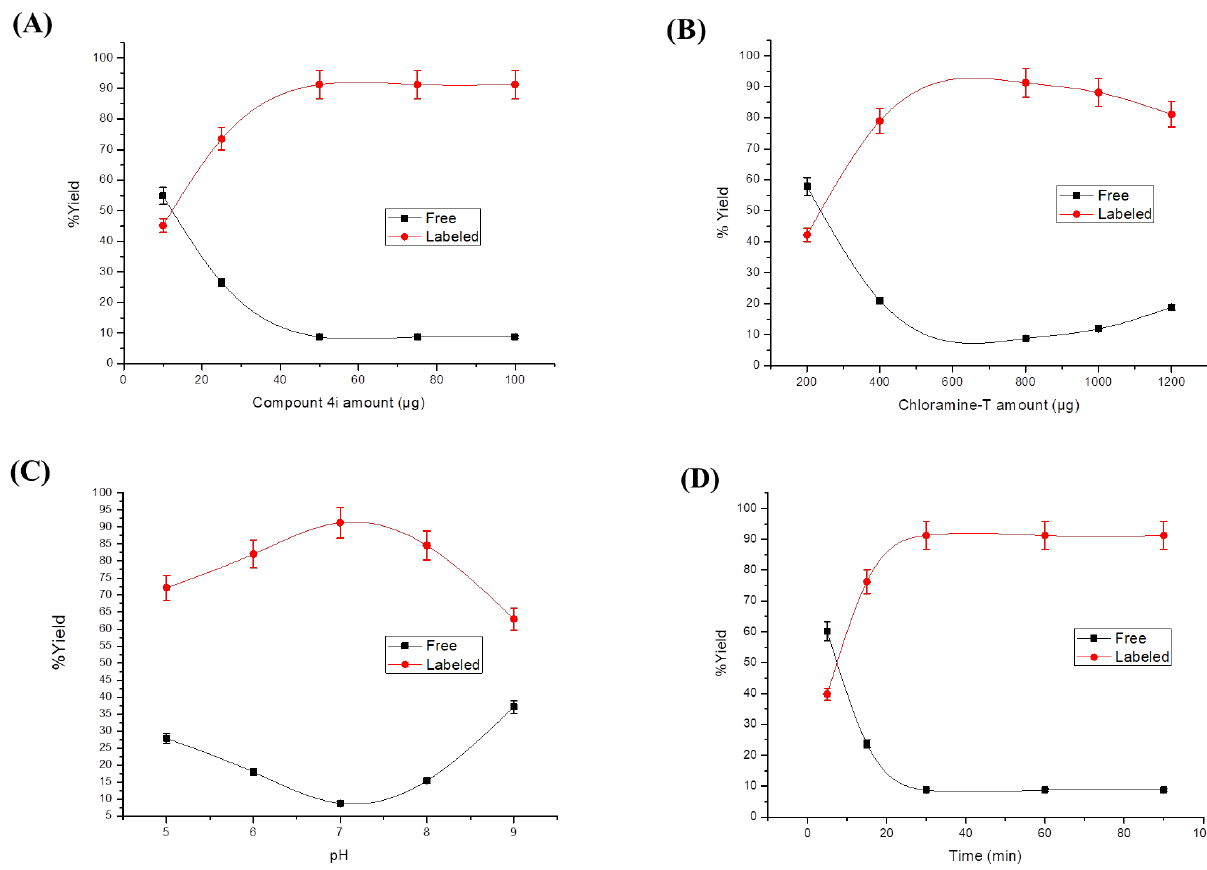
Figure 8. The variation of radiosynthesis yield of the radioiodinated- 4i compound in relation to ( A ) compound 4i amount, ( B ) chloramine-T amount, ( C ) pH, and ( D ) reaction time. Radioactive In Vivo Tracing Studies of Radioiodinated- 4i in a Sarcoma-Bearing Mice